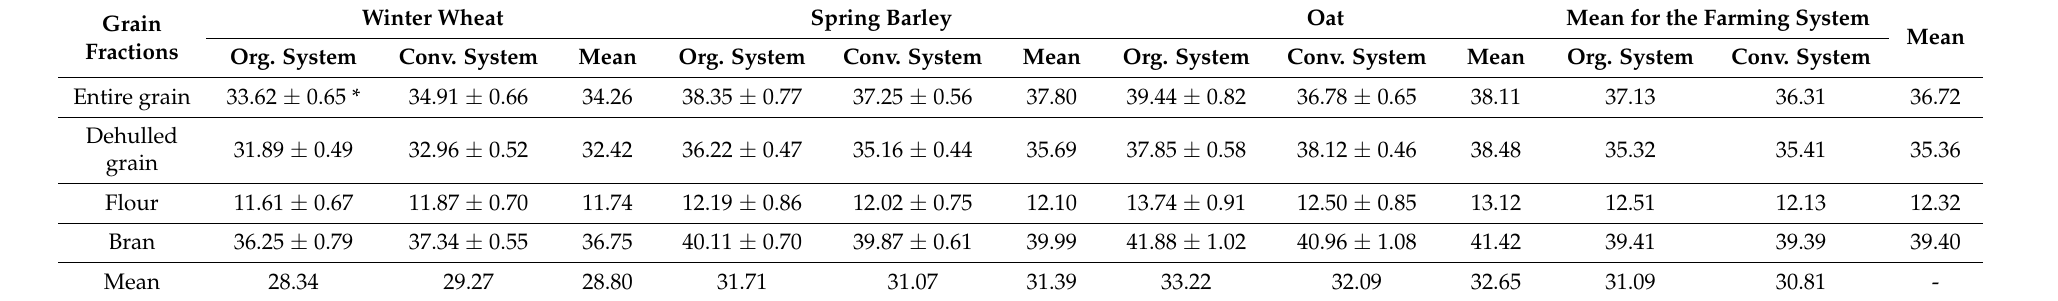
Table 4. Effect of grain milling on antioxidant activity (%) in the β -carotene/linoleic acid system—2017–2019